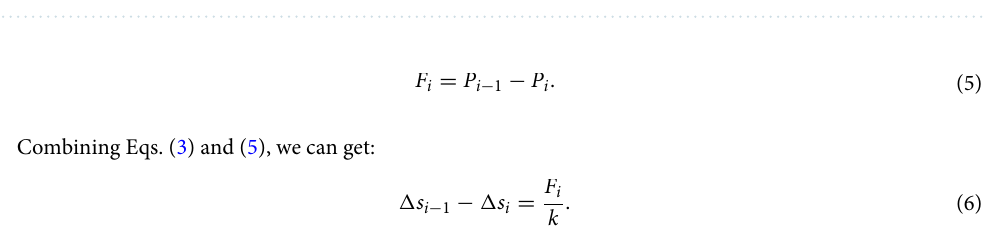
Figure 3. Force analysis diagram of the i -th